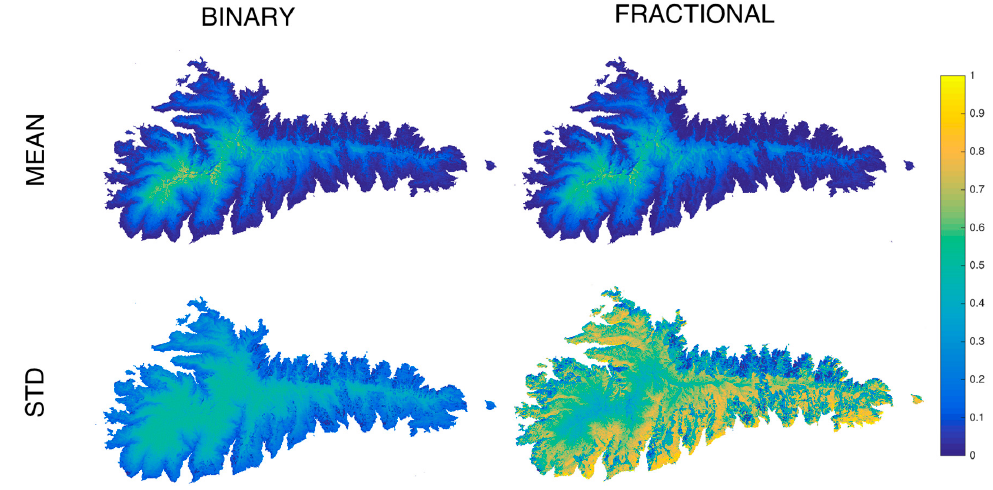
Figure 4. Distribution of the mean and standard deviation of the SCF (m 2 m − 2 ) over the study area during the study period 2000–2013 using a binary and a fractional algorithm. during the study period 2000–2013 using a binary and a fractional